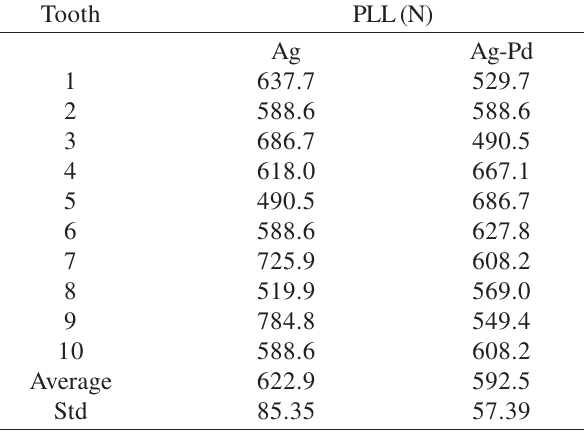
Table 1. Proportional Limit Loads (PLL) of the